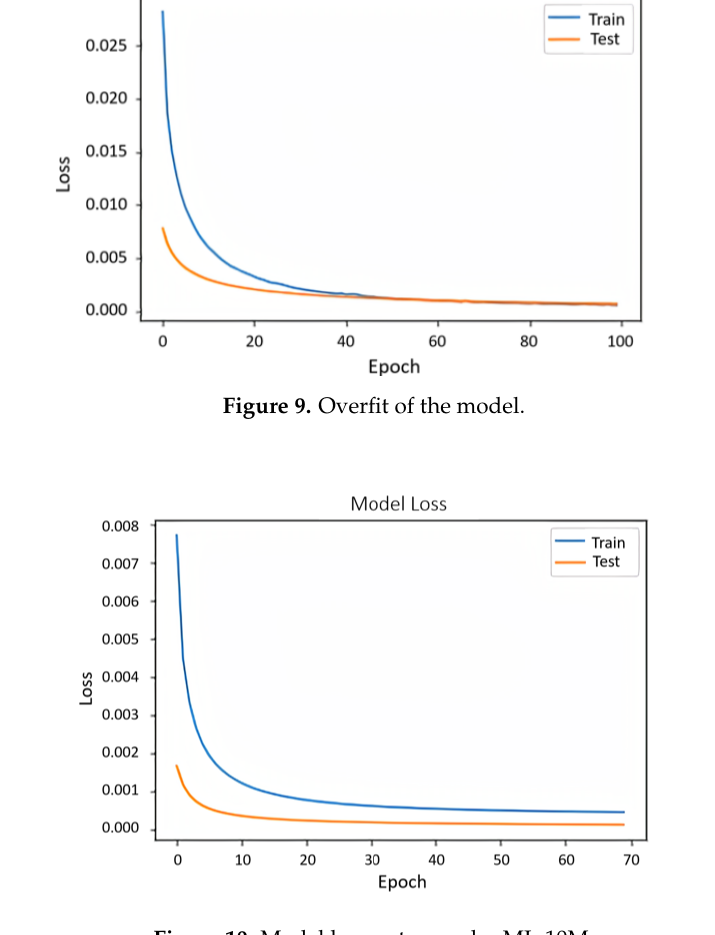
Figure 10. Model loss autoencoder ML-10M.